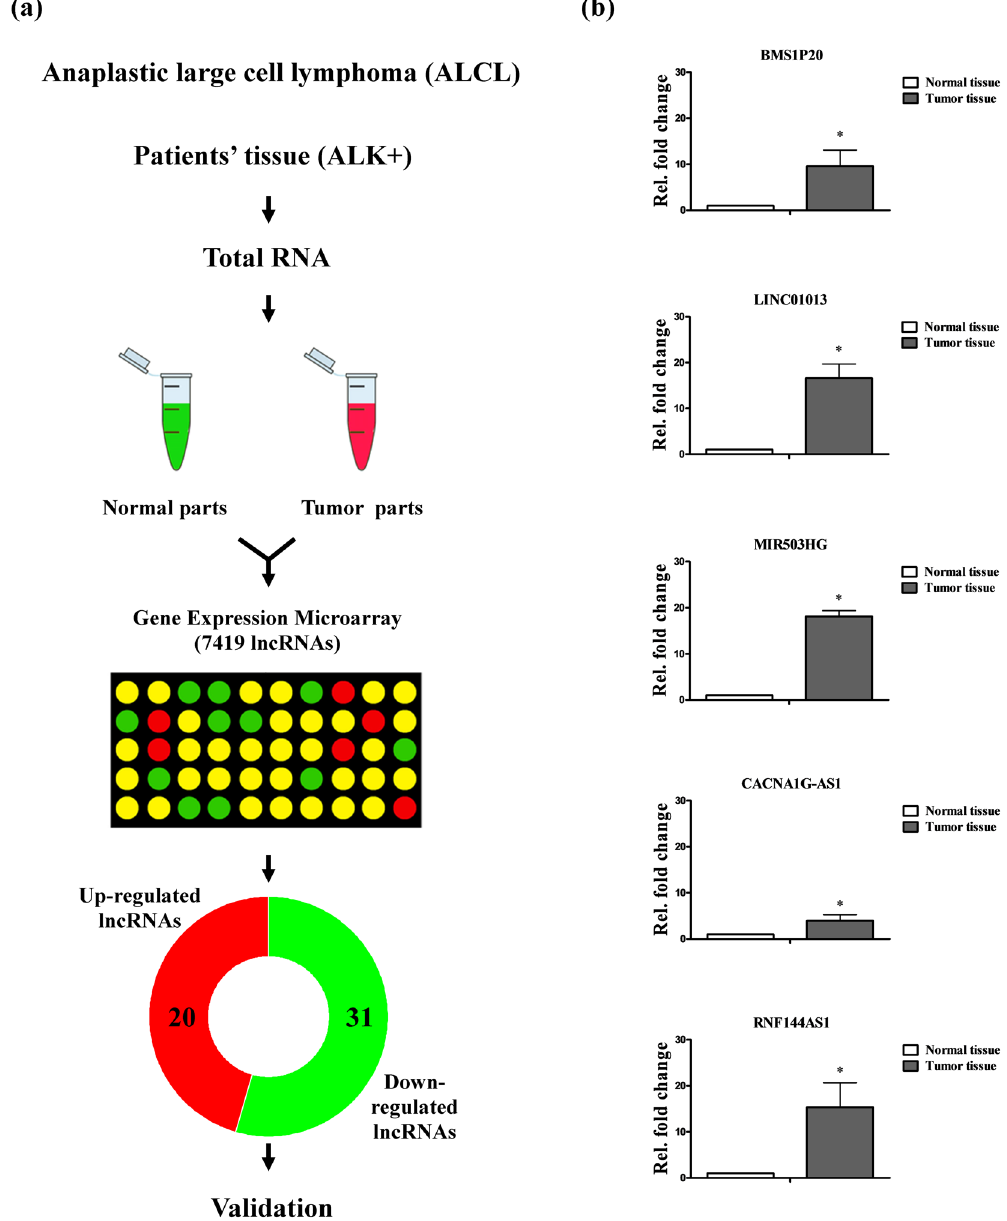
Figure 1. Analysis and validation of lncRNAs in ALCL specimens. ( a ) Schematic diagram showing application of gene expression microarrays (~7419 lncRNAs) to the analysis of lncRNAs. These lncRNAs were selected based on the cut-off value. The 20 up-regulated (fold change > 2.0) and 31 down-regulated (fold change < 0.5) lncRNA were filtered and narrowed down form data base. ( b ) Expression levels of LncRNAs in ALCL specimens (3 paired specimens of patients) were measured by q-RT-PCR. Differences were analyzed using a Kruskal-Wallis test ( * P <